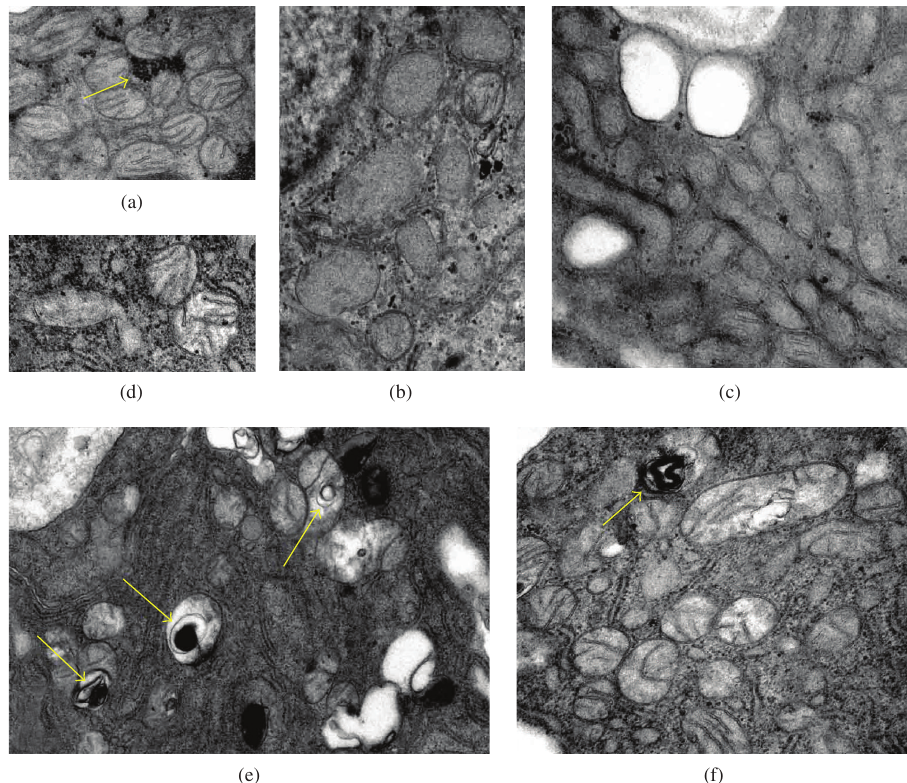
FIGURE 4: Ultrastructural changes in the hepatopancreas of B. aeruginosa exposed to the suspension of M. aeruginosa and mixed algae, respectively. (a) Mitochondria and glycogen (yellow arrow) of control snail, 50000x. (b) The swelling and vesiculation of mitochondria in the mixed group at 10 days postexposure, 50000x. (c) The loss of cristae and matrix in mitochondria in the cyanobacterial group at 15 days postexposure, 50000x. (d) Most mitochondria recovered considerably at the end of the experiment in the mixed group, 50000x. (e) The occurrence of myelinated structures (yellow arrow) in matrix of mitochondria in the cyanobacterial group at 15 days postexposure, 32000x. (f) The recovery of mitochondria and myelinated structures (yellow arrow) at the end of the experiment in the cyanobacterial group,